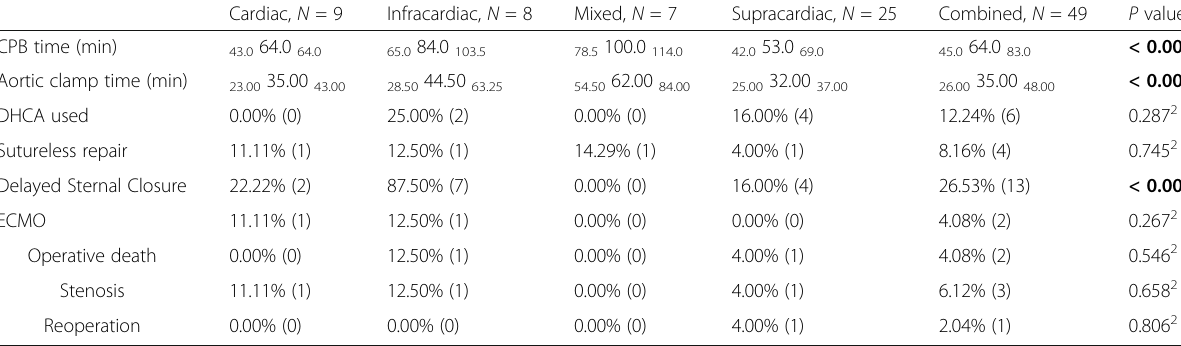
Table 2 Operative and outcome statistics ( N =